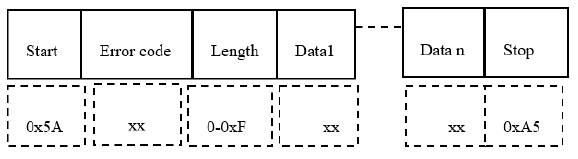
Figure 5. The structure of an answer telegram.